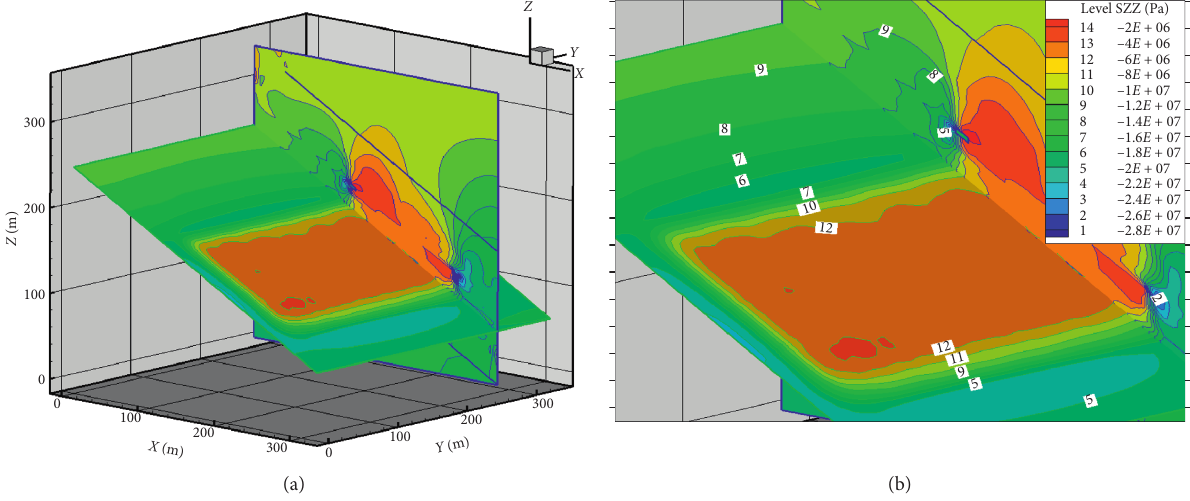
Figure 16: Vertical stress distribution in the 12124 working face after the completion of mining in the 12125 working face. (a) 3D section of the mining area (along the working face dip). (b) An enlarged image of part of the working face.